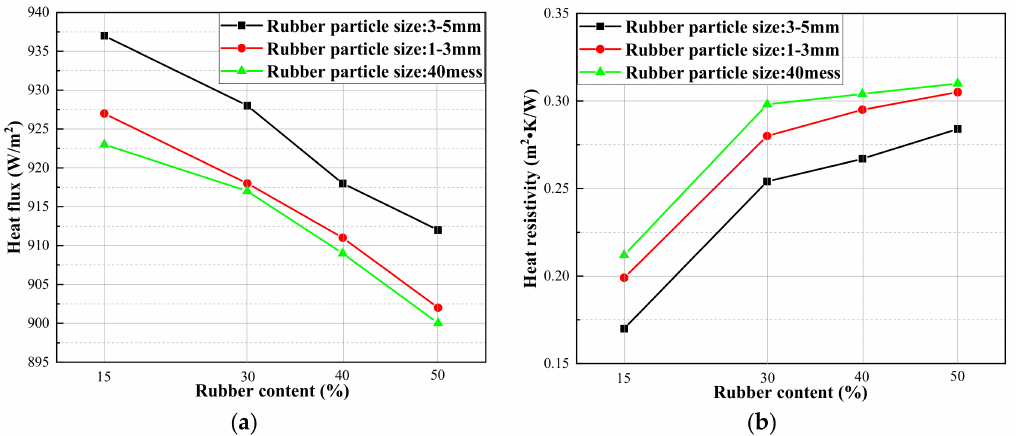
Figure 14. Variation of heat flux and heat resistivity of each specimen: ( a ) Variation of heat flux each specimen and ( b ) variation of heat resistivity of each